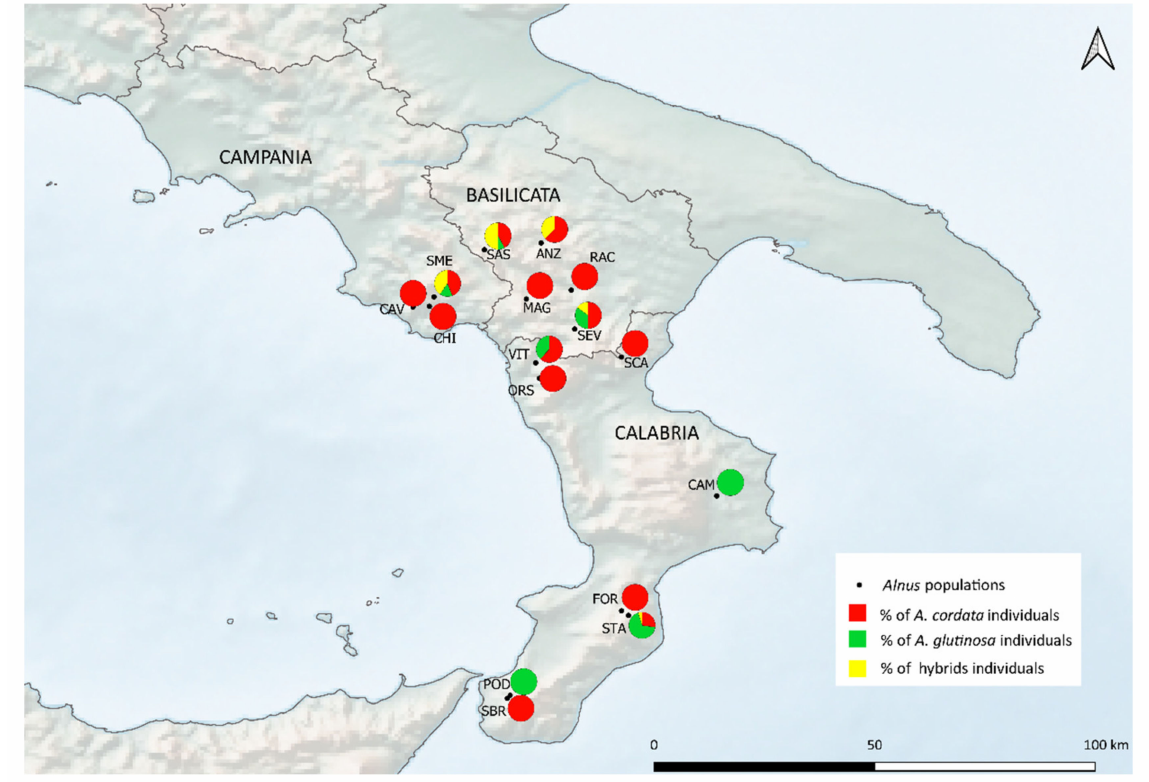
Figure 3. Partitioning of individuals in pure species A. cordata and A. glutinosa , hybrids and backcrosses, after NEWHYBRID genetic analysis of 16 A. cordata and A. glutinosa populations analyzed in this study. Pie diagrams show the percentage of individuals assigned to the different taxonomic categories in each population. Map created using QGIS 3.12 software.